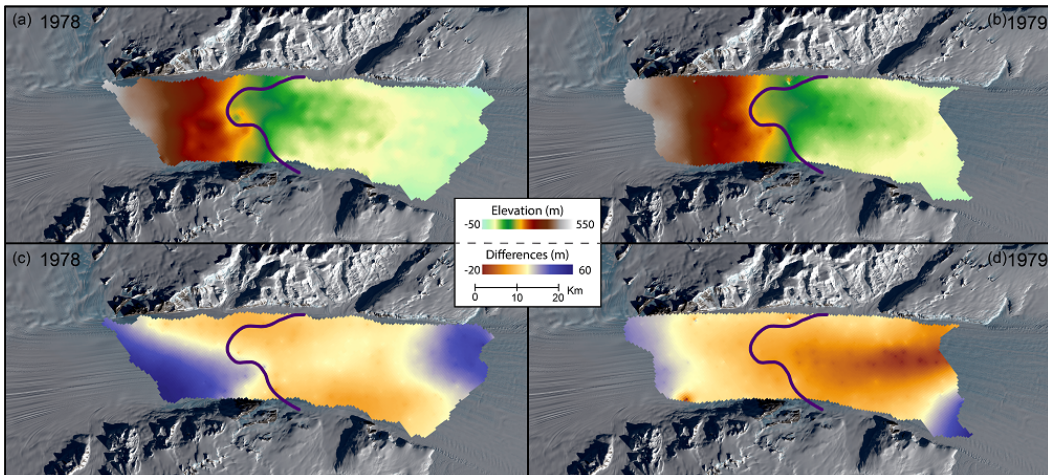
Figure 7. 1978 ( a ) and 1979 ( b ) are Brecher’s [14] elevation data converted from the International 1924 ellipsoid to WSG84 XZY values. 1978 ( a ) and 1979 ( b ) DEMs interpolated from the WGS84 XYZ values converted from the International 1924 ellipsoid. ( c , d ) are the 1978 and 1979 interpolated grid results from differencing the originally processed elevations from the SfM elevations.Note that while there are two separate color bars, the scale bar is the same for all four maps.